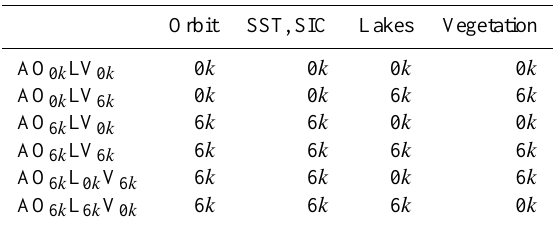
Table 2. Experimental setup including orbital parameters, sea sur- face temperature (SST) and sea ice cover (SIC), lake and vegeta- tion cover; 0 k refers to pre-industrial and 6 k to mid-Holocene con- ditions. While differences in AO conditions apply globally, differ- ences in L and V conditions apply only to the Saharan box (17 ◦ W– 40 ◦ E; 10–30 ◦ N).